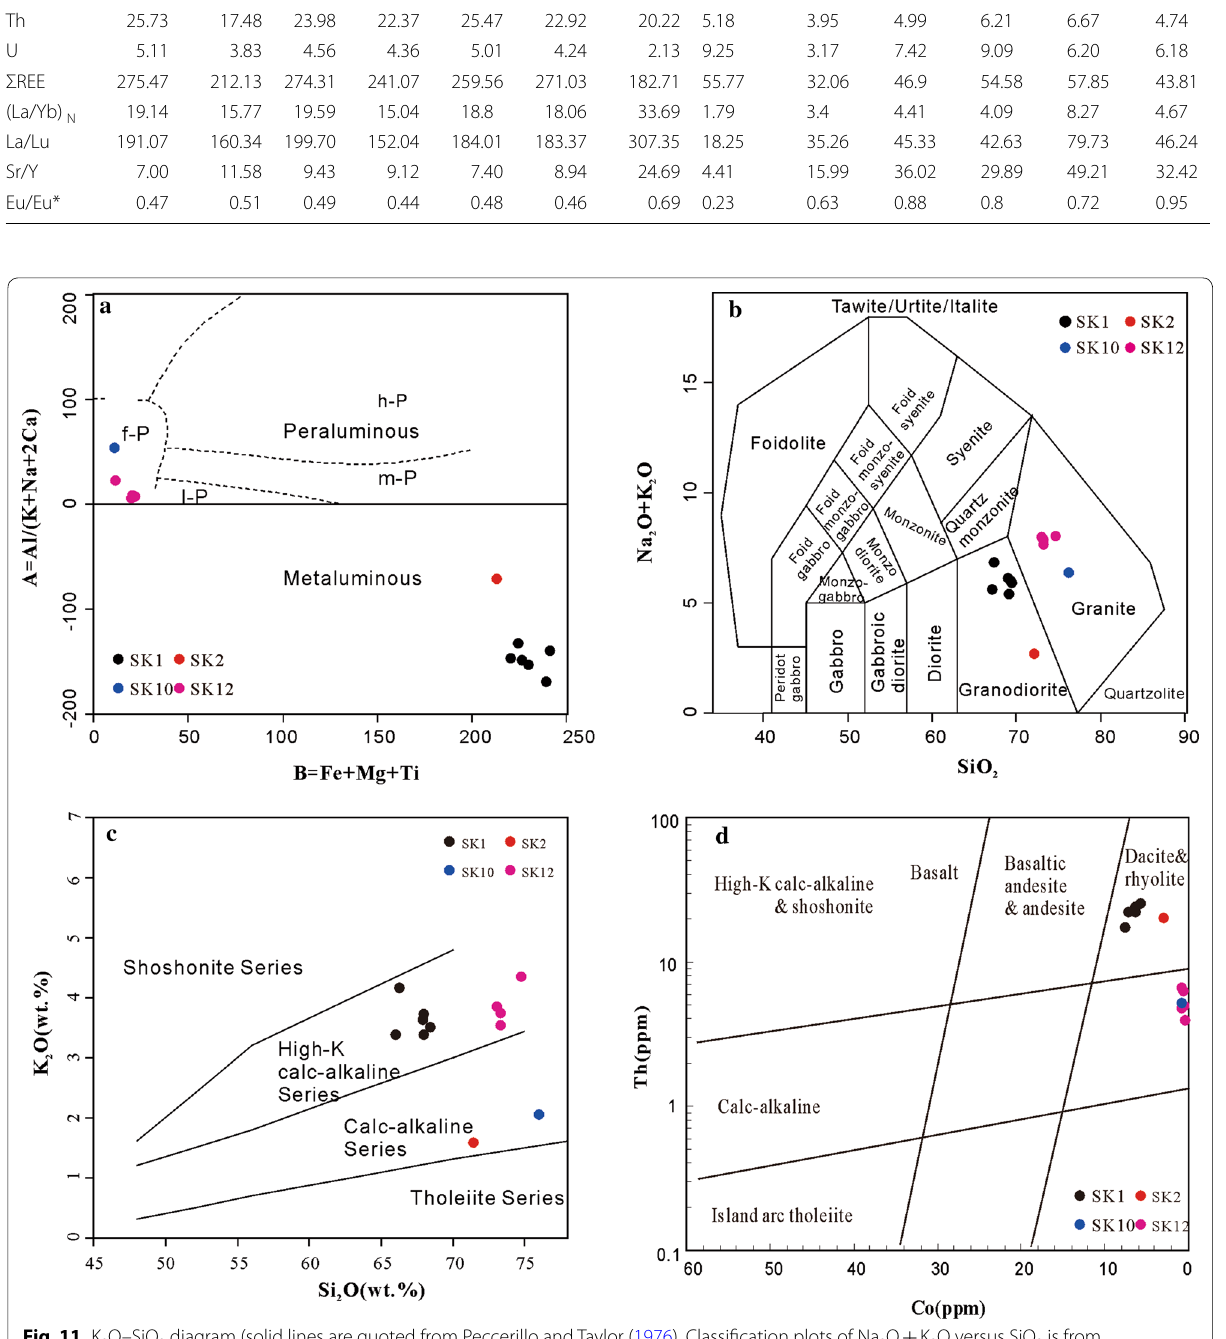
Fig. 11 K 2 O–SiO 2 diagram (solid lines are quoted from Peccerillo and Taylor (1976). Classification plots of Na 2 O Middlemost (1994). The A-B diagram is from Debon and Le Fort (1983), the Co–Th classification diagram from Hastie et al.